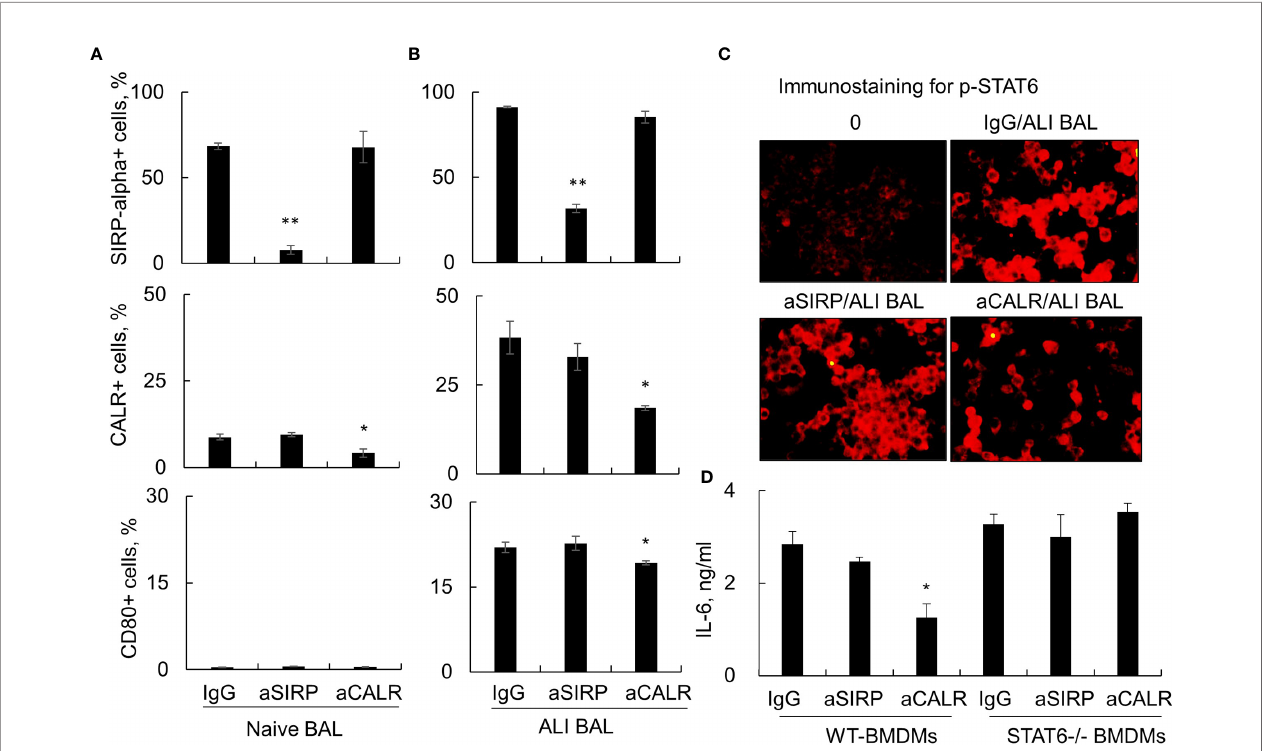
FIGURE 4 | Anti-calreticulin (aCALR) did not suppress acute lung injury (ALI) bronchoalveolar lavage (BAL)-induced macrophage activation and interleukin (IL)-6 expression in signal transducer and activator of transcription (STAT)6-/- bone marrow-derived macrophages (BMDMs). (A, B) Flow cytometry analysis for the expression of SIRP-alpha, CALR, and CD80 on RAW264.7 cells. The cells were pretreated with 2 µg/ml aSIRP, aCALR, or immunoglobulin G (IgG) isotype control for 1 h prior to stimulation with naive or ALI BAL (1:3 dilution). Data were presented as mean ± SE, n = 3, *p < 0.05, **p < 0.01 vs . IgG control. (C) Immunostaining for activated STAT6 (p-STAT6 at Tyr641 residue) in the treated RAW264.7 cells. The cells were incubated with rabbit anti-p-STAT6 antibody (1:200 dilution) and followed by Cy3 conjugated anti-rabbit IgG (1:400 dilution). Representative photograph with magni fi cation ×200. (D) ELISA analysis for the expression of IL-6 in the supernatants of treated wild-type (WT) and STAT6-/- derived BMDMs. Data were presented as mean ± SE, n = 3, *p < 0.05, **p < 0.01 vs . IgG